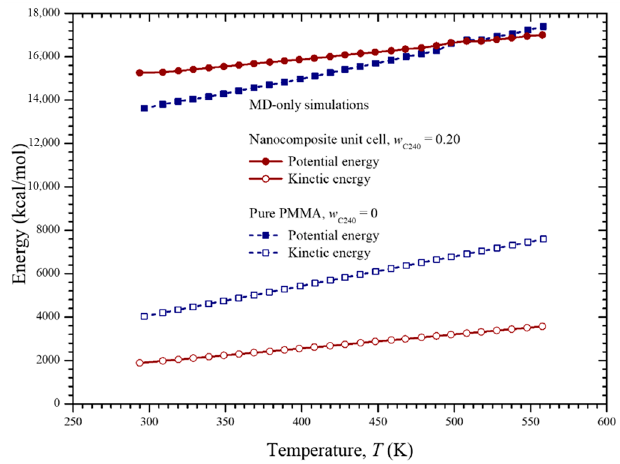
Figure 7. Potential and kinetic energy of the pure PMMA and nanocomposite with w C240 = 0.2 with respect to the temperature.